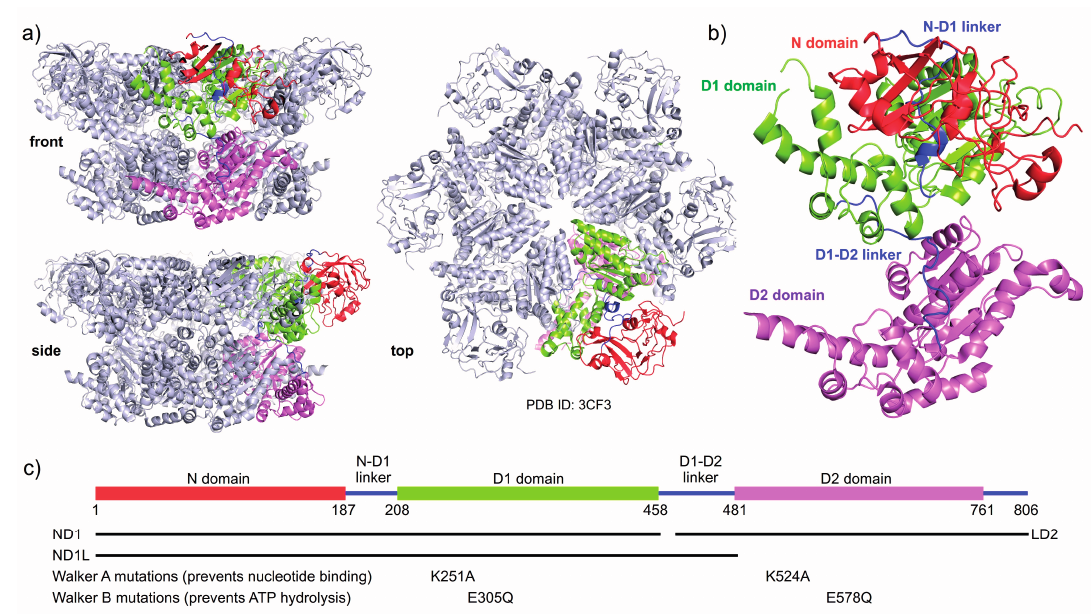
Figure 1. Structure of the AAA+ chaperone p97. ( a ) The structure of the p97 hexamer rendered from PDB ID 3CF3 providing front, side, and top views denoting the positions of the N domain (red), the D1 domain (green), and the D2 domain (magenta) within one subunit; ( b ) Close up of a single subunit illustrating the N domain, D1 domain, and D2 domain along with the N-D1 and D1-D2 linker regions (blue); ( c ) The domain architecture of p97 by amino acid number colored as in a and b (top). A series of deletion and point mutations used by many research groups to dissect the mechanism of p97